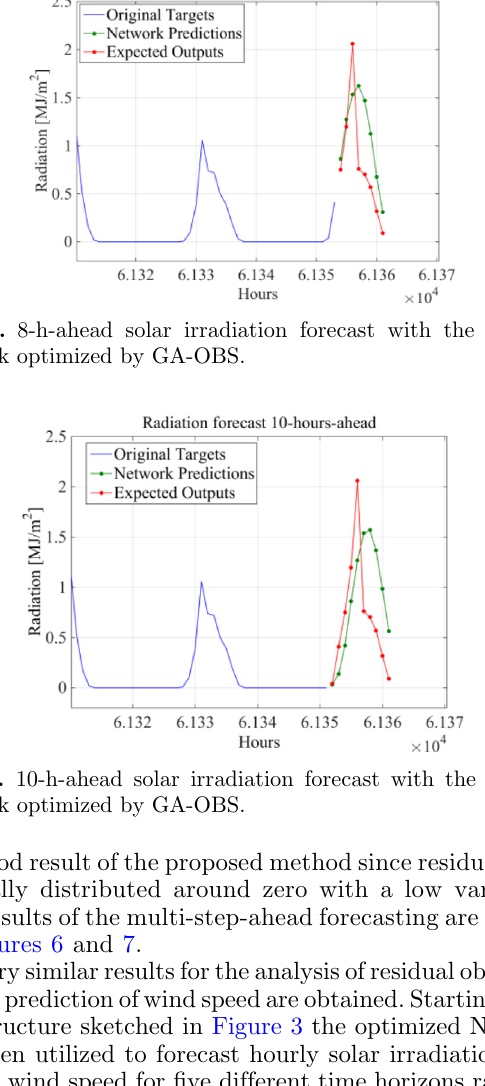
Table 1. The best forecasting results are obtained for 8 and 10 h for solar irradiation and for 18 and 24 h for wind speed.